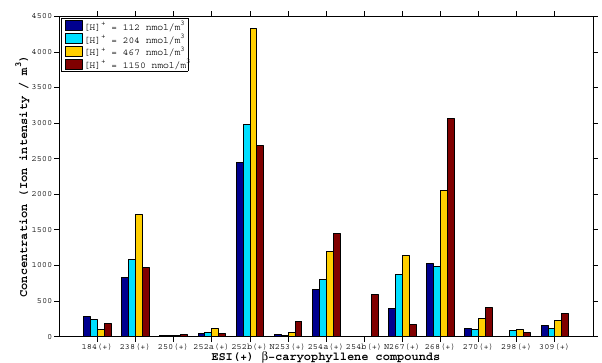
Fig. 1. Concentration of compounds detected by ESI in positive ion mode in the series of β -caryophyllene/NO x irradiation experiments. Chemical formulas and proposed chemical structures of these com- pounds are given in Table 2.